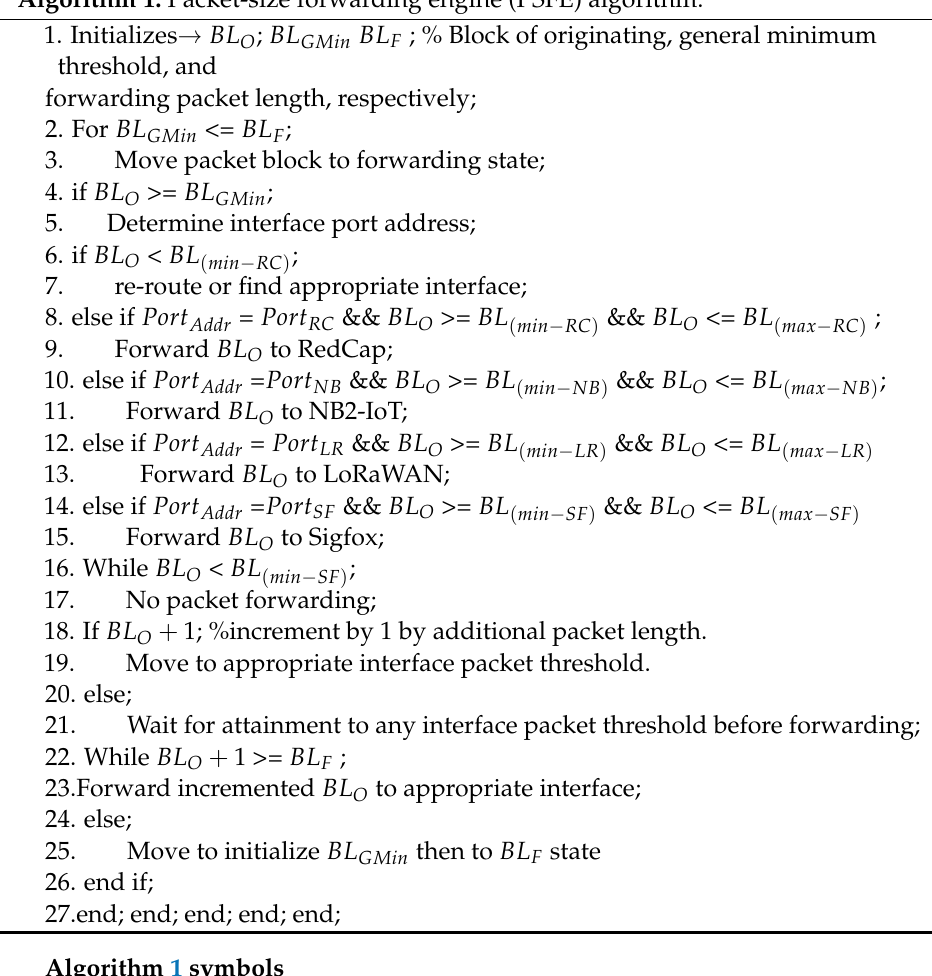
Algorithm 1 symbols